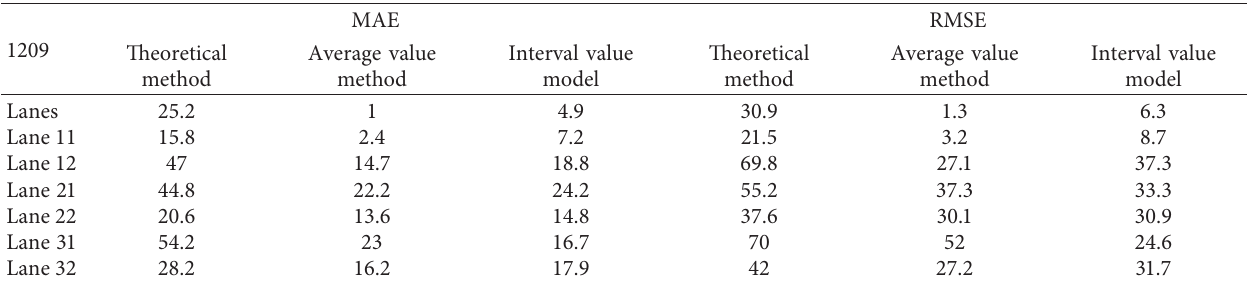
Table 5: Data fitting accuracy by MAE and RMSE on December 9,